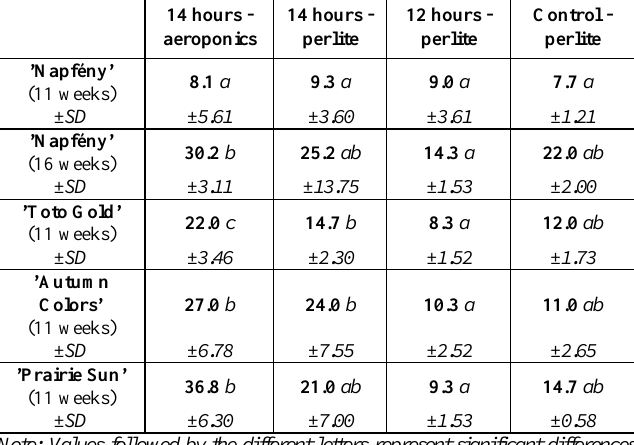
Figure 5. Lengths of 11 weeks-old Rudbeckia hirta L. varieties (’Napfény’, ’Autumn Colors’) depending on photoperiodic lighting treatments, peat-free